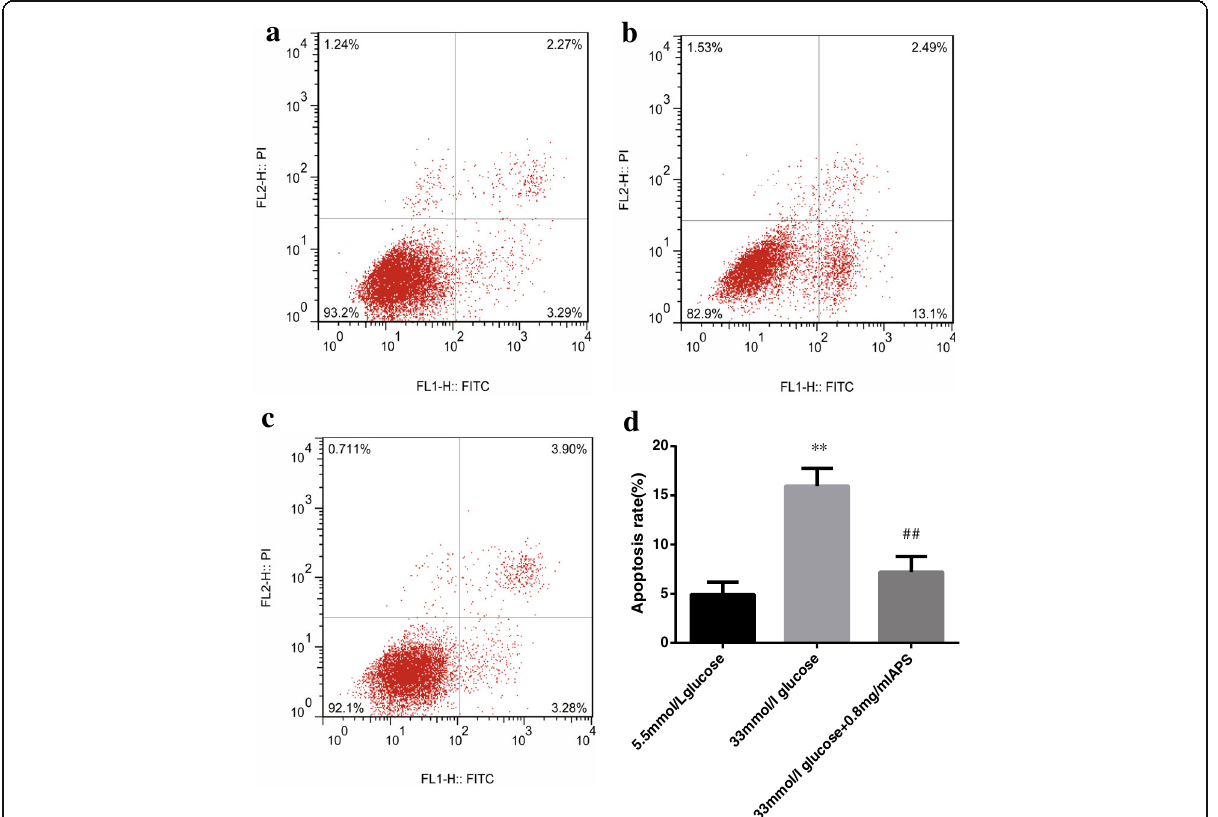
Fig. 3 Cell apoptotic rates measured by flow cytometry using annexin V-FITC/PI staining. H9C2 cells were pre-incubated with/without APS for 24 h and then treated with 33 mmol/L glucose for 24 h. Cells were harvested and detected with a flow cytometer. a . 5.5 mmol/L glucose group. b . 33 mmol/L glucose group. c . 33 mmol/L glucose and 0.8 mg/mL APS group. Data were expressed as Mean ± SD. ** P < 0.01 versus 5.5 mmol/L glucose group; ## P < 0.01 versus 33 mmol/L glucose